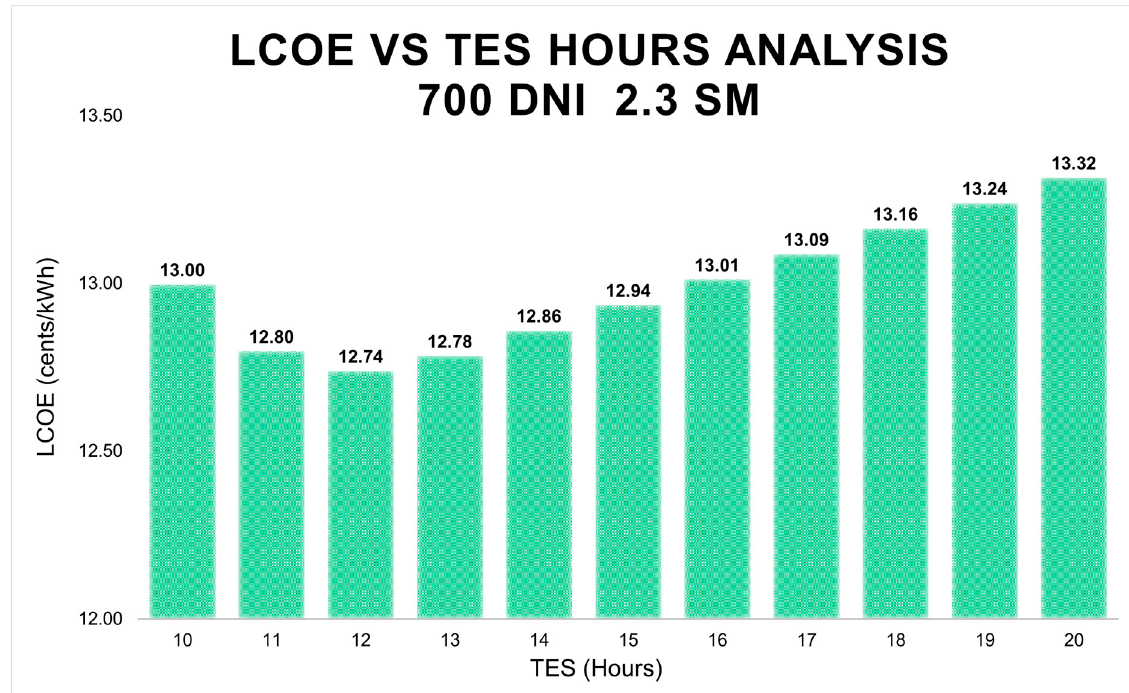
Figure 15. Sensitivity analysis of solar field variations for DNI 700 W/m 2 and 2.3 SM.